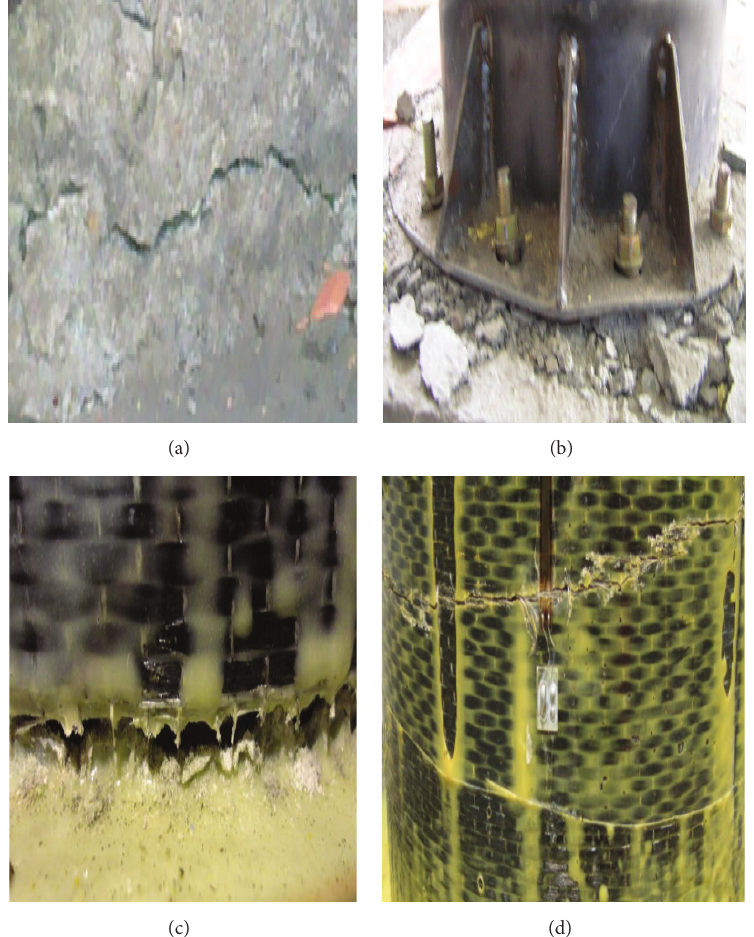
Figure 5: Failure modes of the specimens: (a) the original specimen; (b) specimen A-R; (c) specimen B-R; (d) specimen C-R.